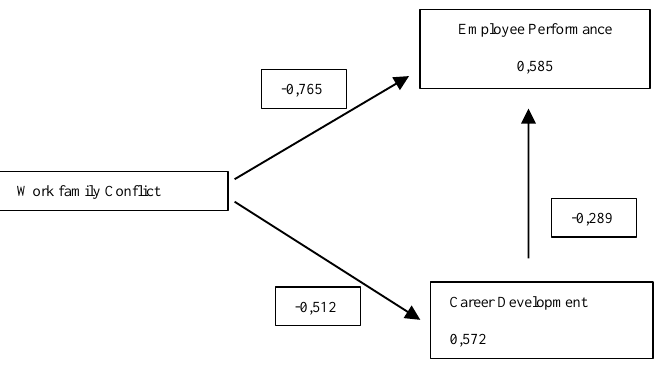
Figure 2 : Effect of exogenous variable on endogenous